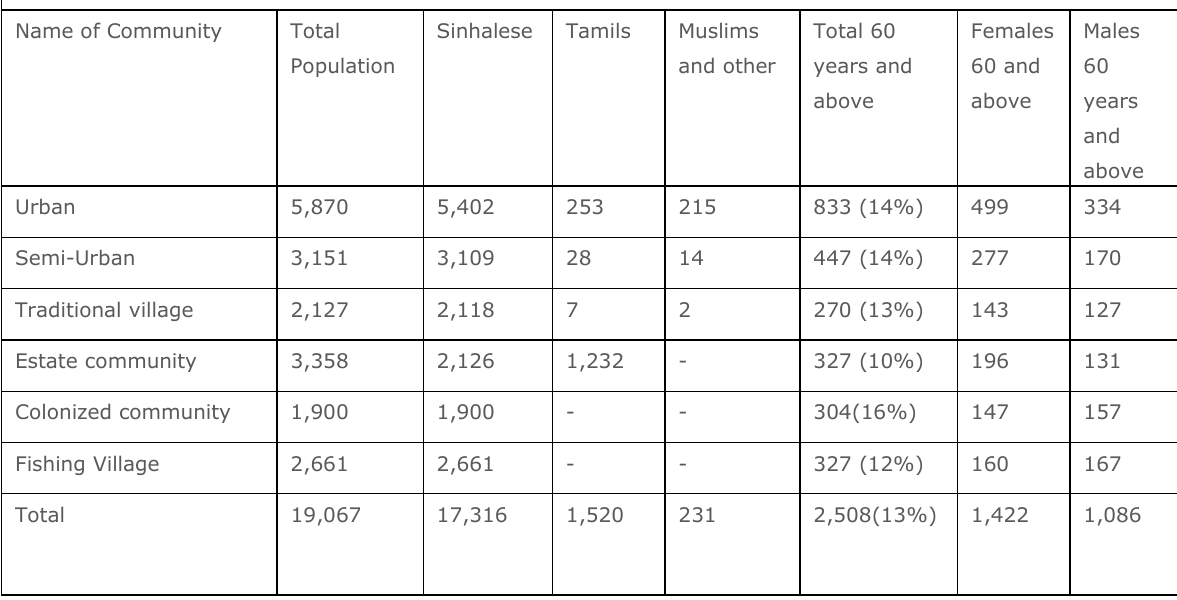
Table 1: Older people and gender distribution in the sample locations Name of